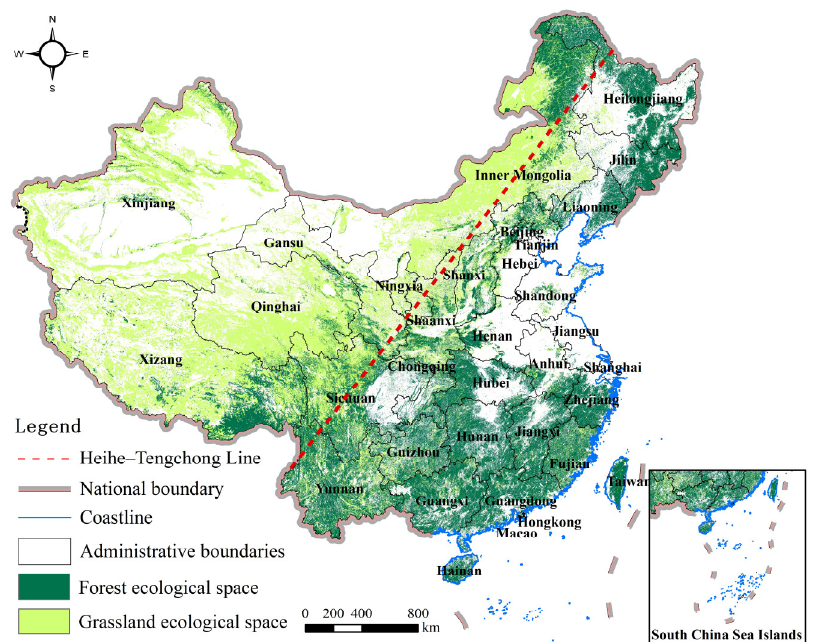
Figure 2. Study Figure 2. Study area.